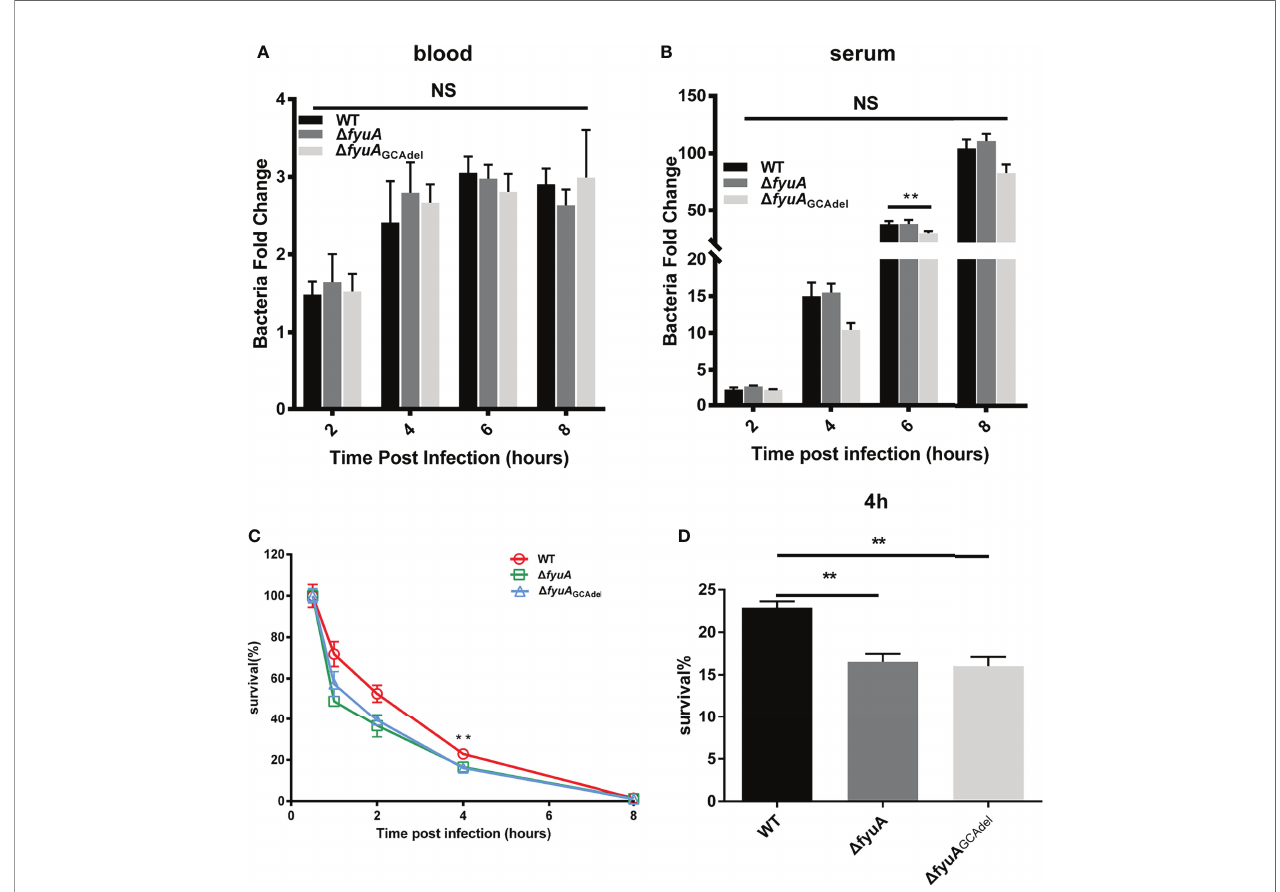
FIGURE 4 | Comparison of the viabilities of WT and the mutants in blood (A) , serum (B) and RAW264.7 cells (C, D) . The survival rates of D fyuA and D fyuA GCAdel mutant strains were lower than that of strain 201 in RAW264.7 cells but showed no signi fi cant differences in blood and serum. The experiments were performed three times independently. **, p < 0.01. NS, not signi fi